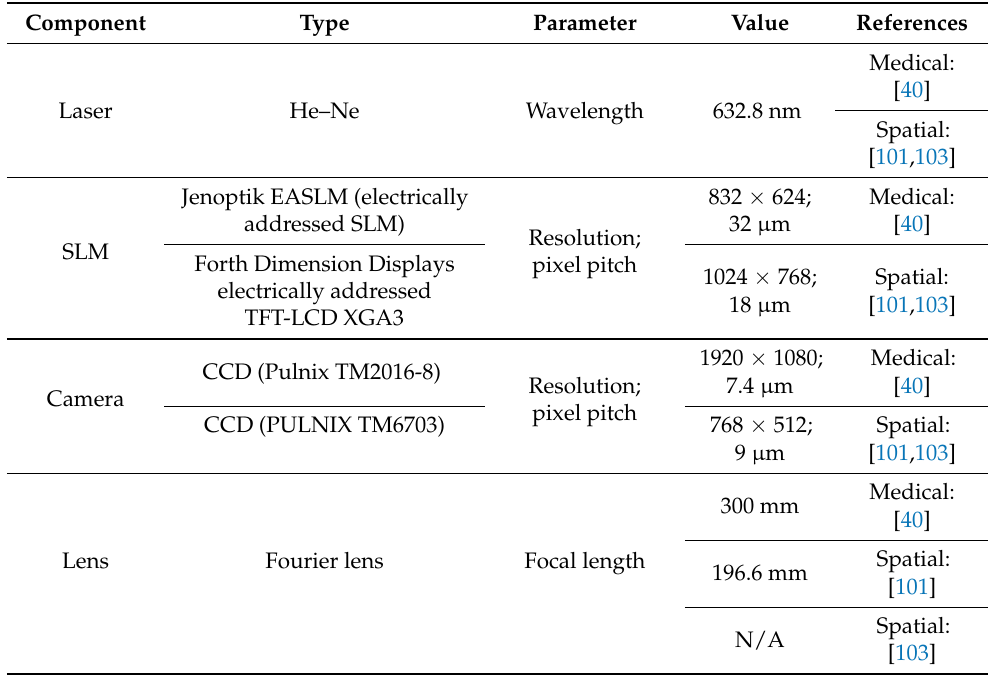
Table 4. Comparison between the most important parameters of the JTC setup in various proposed architectures, in medical and spatial